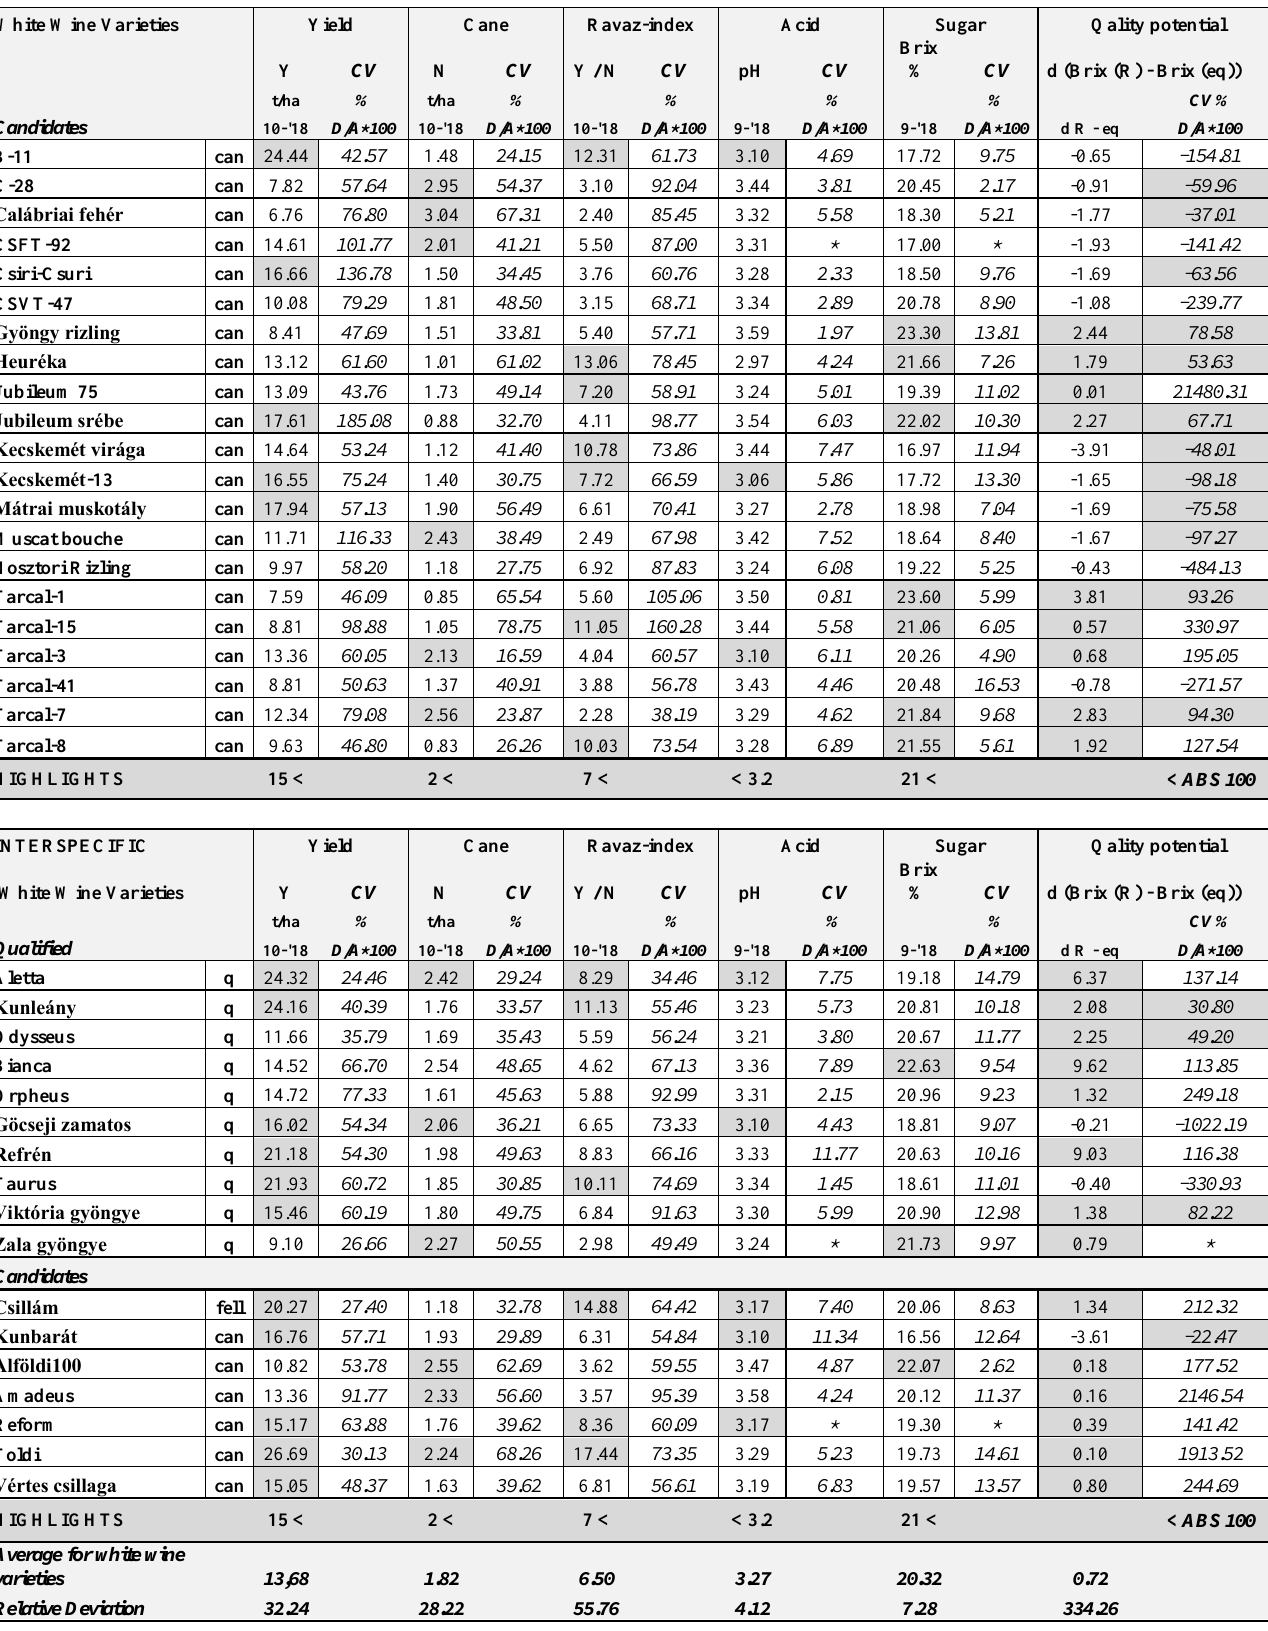
Table 3. Production and flexibility data of candidate Vitis vinifera (L.) and intespecific (qualified and candidate) white wine grape varieties (Pallag, 2010-2018). White Wine